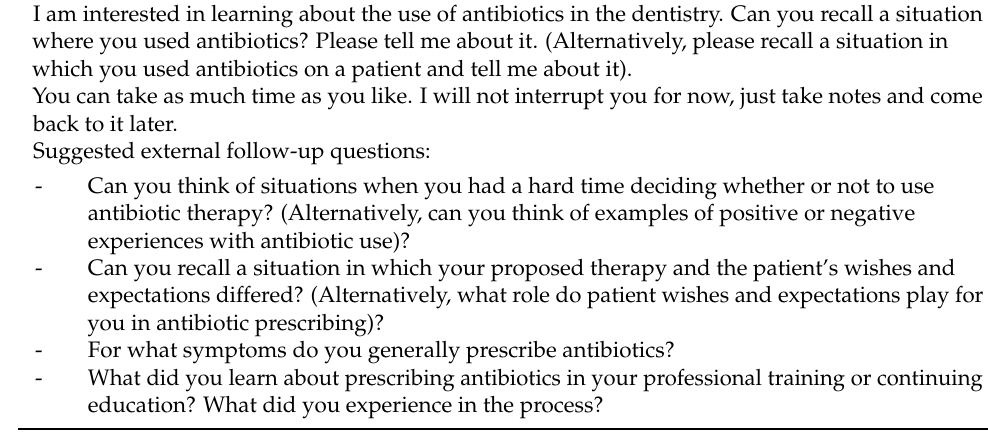
Table 2. Interview